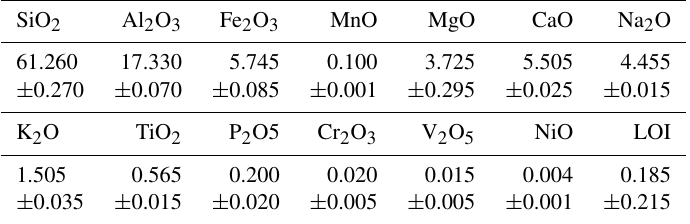
Table 1. Major element (oxide) composition, determined via X-ray fluorescence analysis. All values are given in weight percent